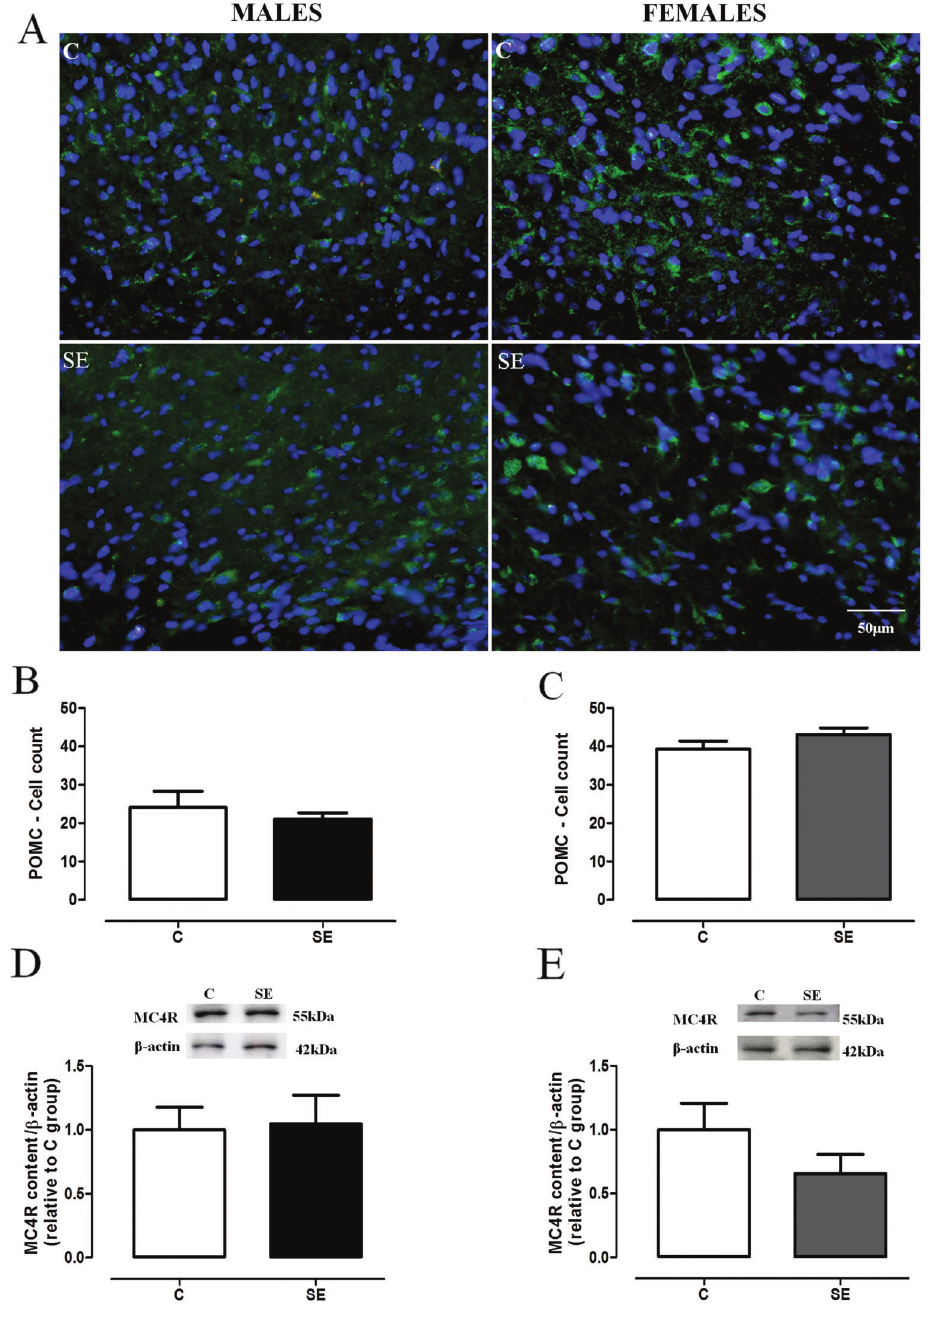
Figure 6. Long-term effects of neonatal cigarette smoke exposure on POMC and MC4R in the hypothalamus. Qualitative data of POMC (in green), counterstained for DAPI (in blue) in arcuate nucleus by immunohistochemistry ( A ) (Scale bar: 50 m m) and quantitative data concerning the number of POMC-positive cells in males ( B ) and females ( C ). Protein content of MC4R in the paraventricular nucleus (PVN) at 180 postnatal days in males ( D ) and females ( E ) with representative blots of proteins. b -Actin content was used as loading control. Data are reported as relative % to the control group. C: control group; SE: smoke-exposed group. Data are reported as means ± SE for n=7 (two-way ANOVA re-examined by one-way ANOVA followed by Newman-Keuls post-hoc test).